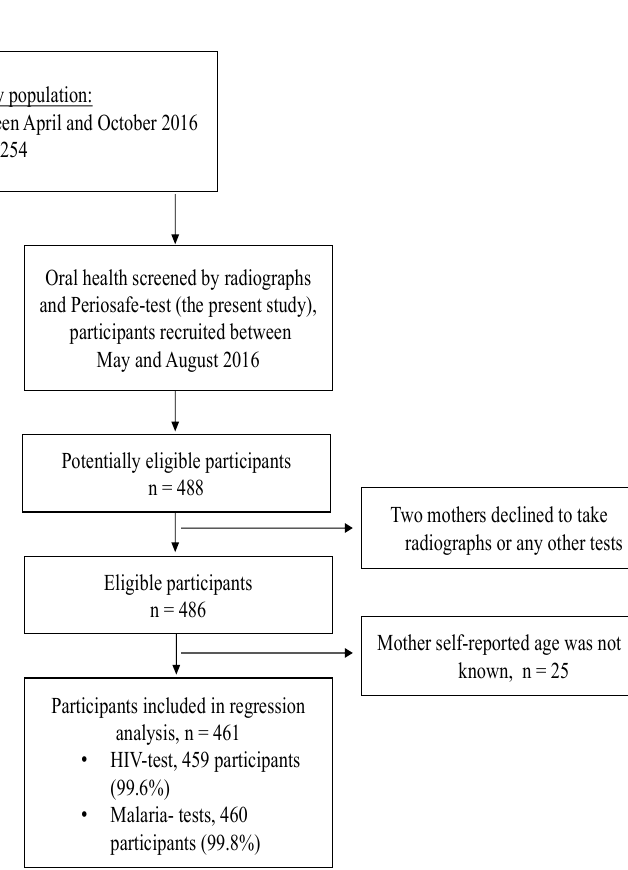
Figure 2. Schematic representation of participant flow.